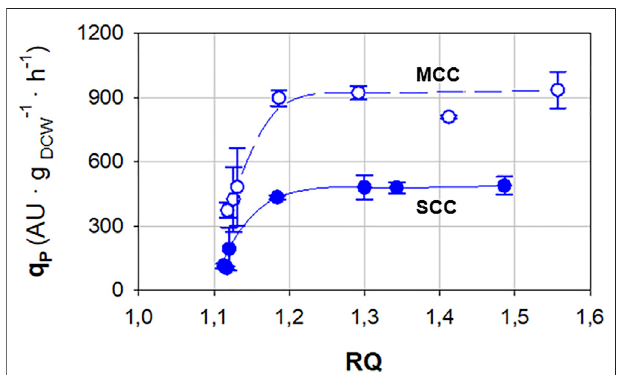
FIGURE 2 | Relationship between speci fi c Crl1 production rate ( q P ) and respiratory quotient ( RQ ) for single-copy clone (SCC, fi lled symbols) and multicopy clone (MCC, void symbols) obtained in chemostat cultures. Error bars represent the SD of biological